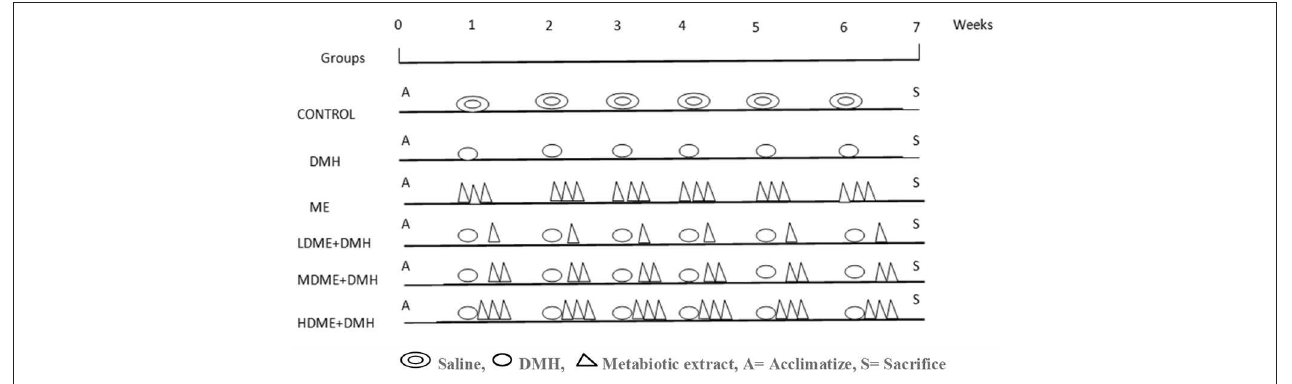
FIGURE 1 | Schematic representation of experimental design for the induction of colon carcinogenesis in Sprague–Dawley (SD) rats by 1,2-dimethylhydrazine (DMH).